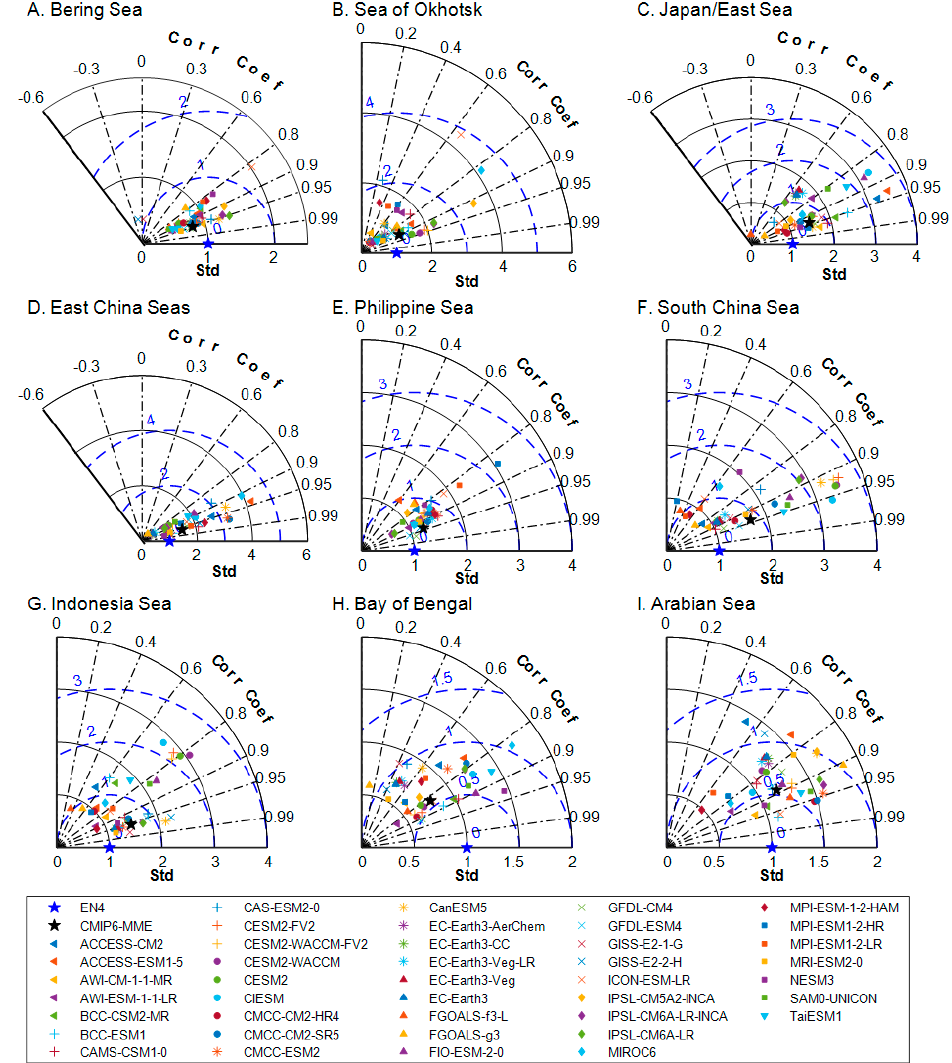
Figure 4. Taylor Diagram of simulated annual mean sea surface salinity (SSS) in different regions of the Asian Marginal Seas (AMSs) in the CMIP6 models. (( A ) Bering Sea, ( B ) Sea of Okhotsk, ( C ) Japan/East Sea (JES), ( D ) East China Seas (ECSs), ( E ) Philippine Sea, ( F ) South China Sea (SCS), ( G ) Indonesian Seas, ( H ) Bay of Bengal, and ( I ) Arabian Sea.) The black solid contours indicate the normalized spatial standard deviation ( σ m / σ o ) with respect to that of EN4 ( σ o ). The dashed blue contours and dashed black lines indicate the centered root-mean-square bias ( E ′ ) and spatial correlation coefficient ( r ) of annual mean SSS between models and EN4, respectively. The EN4 is defined as the reference point (blue pentagram), with normalized spatial standard deviation ( σ o / σ o ), E ′ , and R equal to 1, 0, and 1, respectively. The black pentagrams donate the CMIP6 multi-model ensemble means (MMEs). The σ m , σ o , E ′ , and R are defined in Section 2.2.